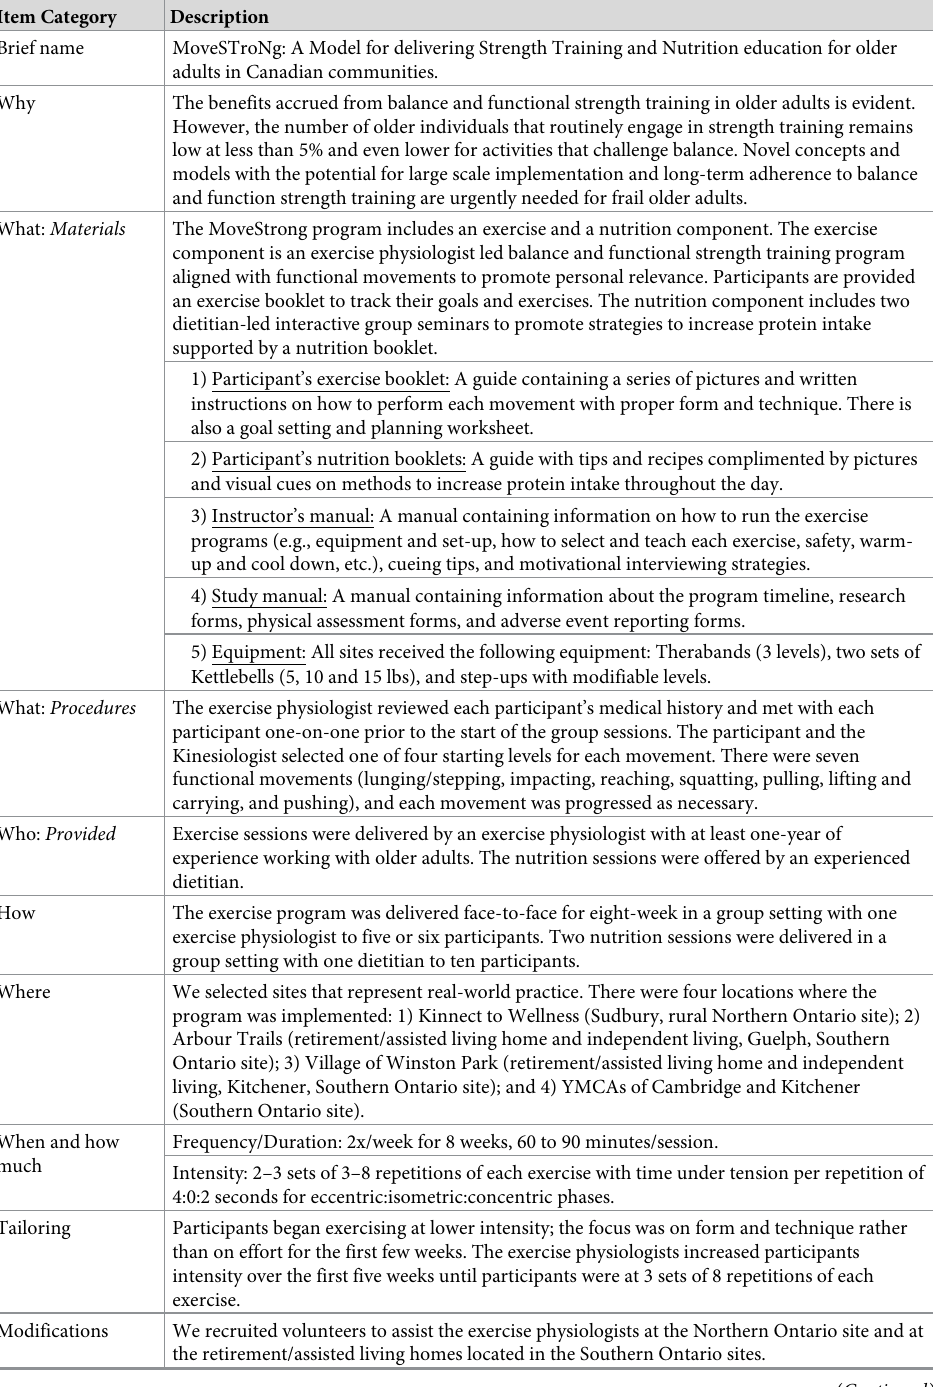
Table 1. Template for intervention description and replication (TIDieR)